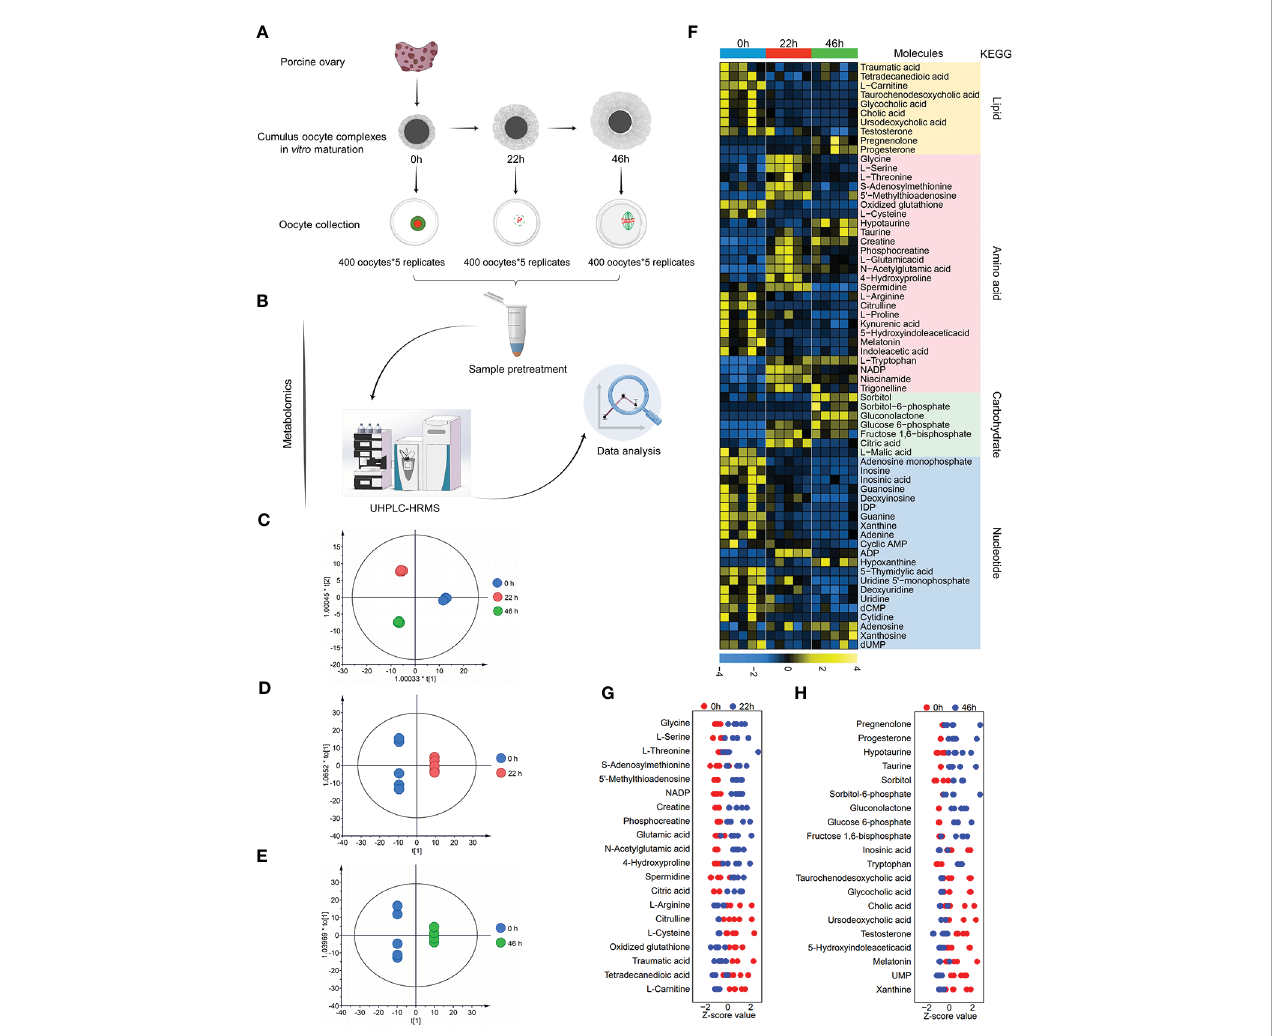
FIGURE 1 Metabolomic pro fi ling of porcine oocyte maturation. (A) Collection of porcine oocytes cultured in vitro at key time points (0h, 22h, 46h). (B) Work fl ow for UPLC/MS-based metabolome pro fi ling on porcine oocytes. (C – E) : OPLS-DA score plot for metabolomic datasets clearly distinguished oocyte samples from three time points. (F) Heatmap visualizing relative abundance of differential metabolites during porcine oocyte maturation, classi fi ed by metabolic pathway. (G) Z-score plots of 20 representative differential metabolites in oocytes in vitro cultured for 0h and 22h (meiotic resumption). (H) Z- score plots of 20 representative differential metabolites in oocytes in vitro cultured for 0 and 46h (meiotic maturation). Each color represents one phase, and each point represents one metabolite in one sample. The complete metabolomic data are available in Supplementary Table